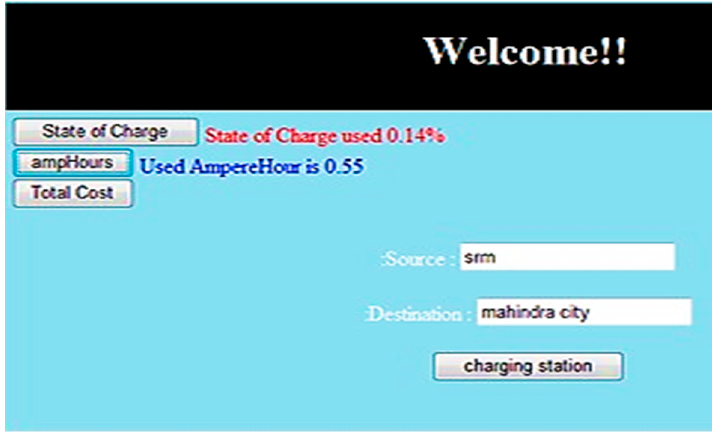
Figure 11. Estimated SOC Value.